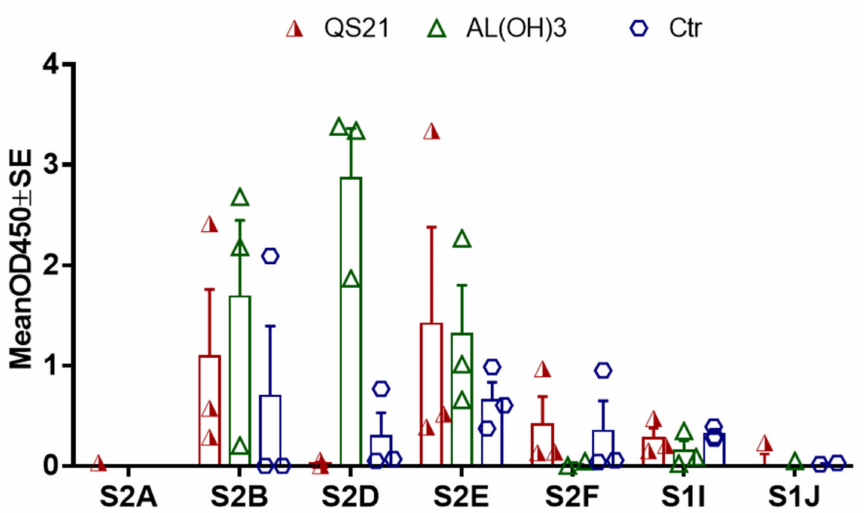
Figure 2. Antibody response to peptide mixture after 2 vaccines. In total, 7 peptides were used in this injection, with either QS21 or Al(OH) 3 as adjuvants. Peptides S1I and S1J are selected from S1 domain. Peptide S2A, S2B, S2D, S2E and S2F are selected from S2 domain. (N = 3, p <